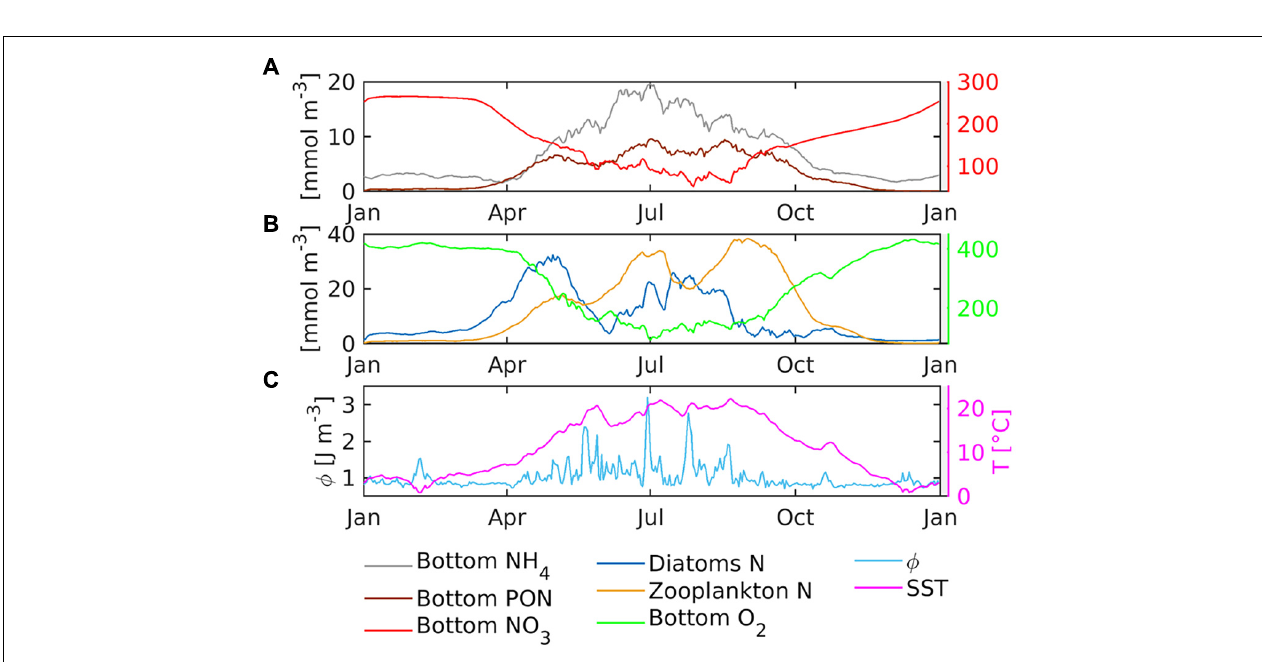
FIGURE 11 | Time series of daily near-bottom (A) ammonium, detritus (PON) and nitrate concentrations, (B) vertically averaged diatoms and zooplankton concentrations and near-bottom concentration of oxygen, (C) daily potential energy anomaly ( (cid:56) ) and sea surface temperature in a major port basin where all time-series represent the spatial average for local depth h > 10m. The location of the port basin is marked by the red dashed line in the top inset in Figure 1 .